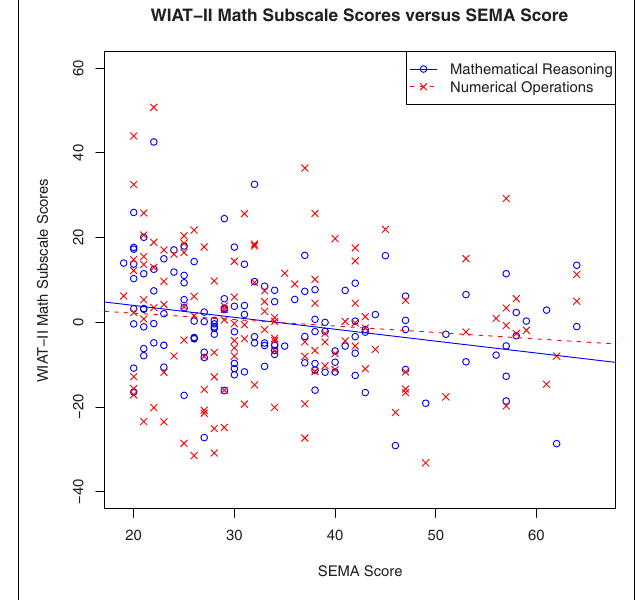
FIGURE 1 | Math anxiety was significantly and negatively correlated with MathAchievement, as measured byWIAT-II Math Composite scores ( R 2 = 0.43). FIGURE 2 | Math anxiety was significantly and negatively correlated withWIAT-II Mathematical Reasoning subtest ( R 2 = 0.57), but not the Numerical Operations subtest ( R 2 = 0.23).The figure above shows corrected means after controlling for FSIQ and trait anxiety.